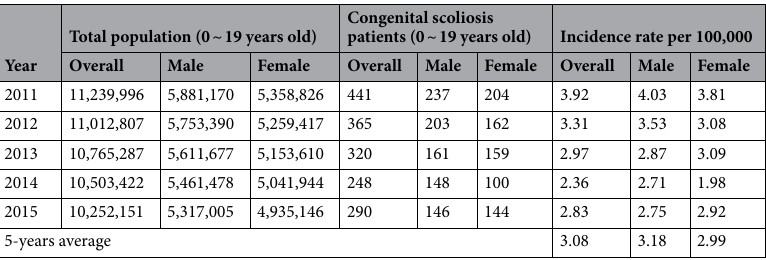
Table 1. Individual annual and 5-years average incidence rate of congenital scoliosis from 2011 to